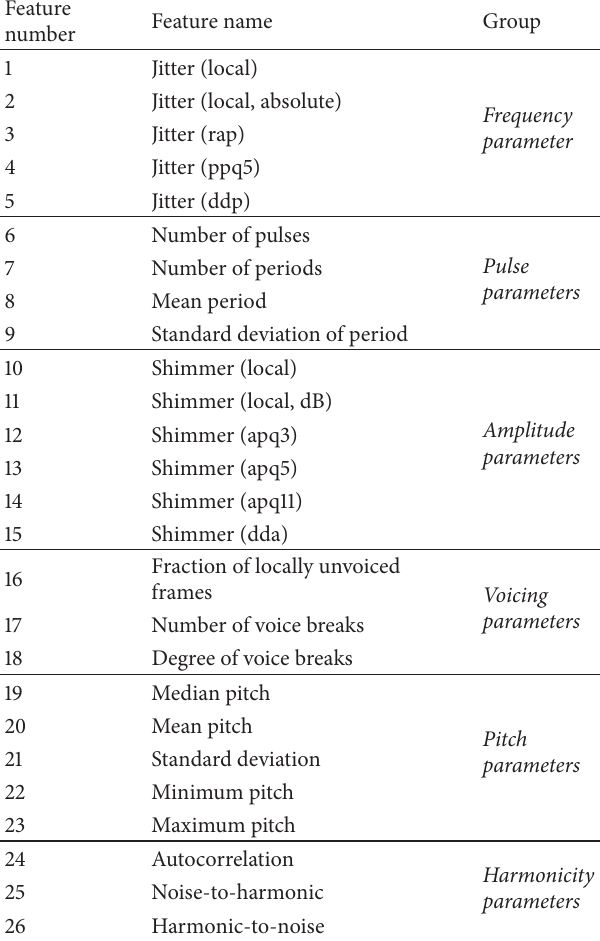
Table 1: Time-frequency based features presented in Parkinson speech dataset with multiple types of sound recordings